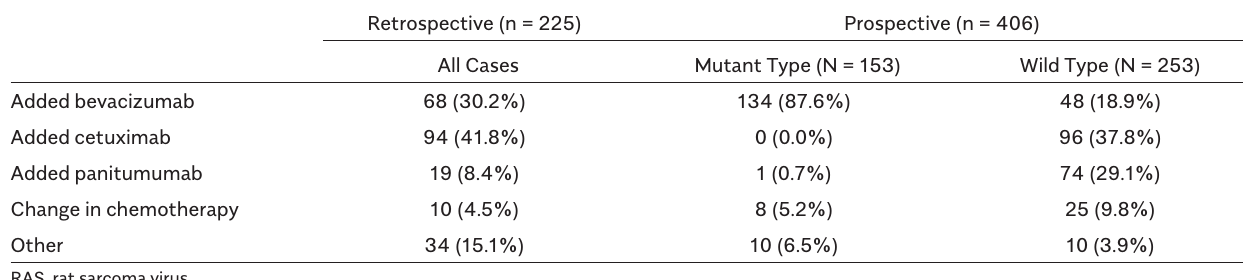
Table 4. Changes to Therapy as a Result of RAS